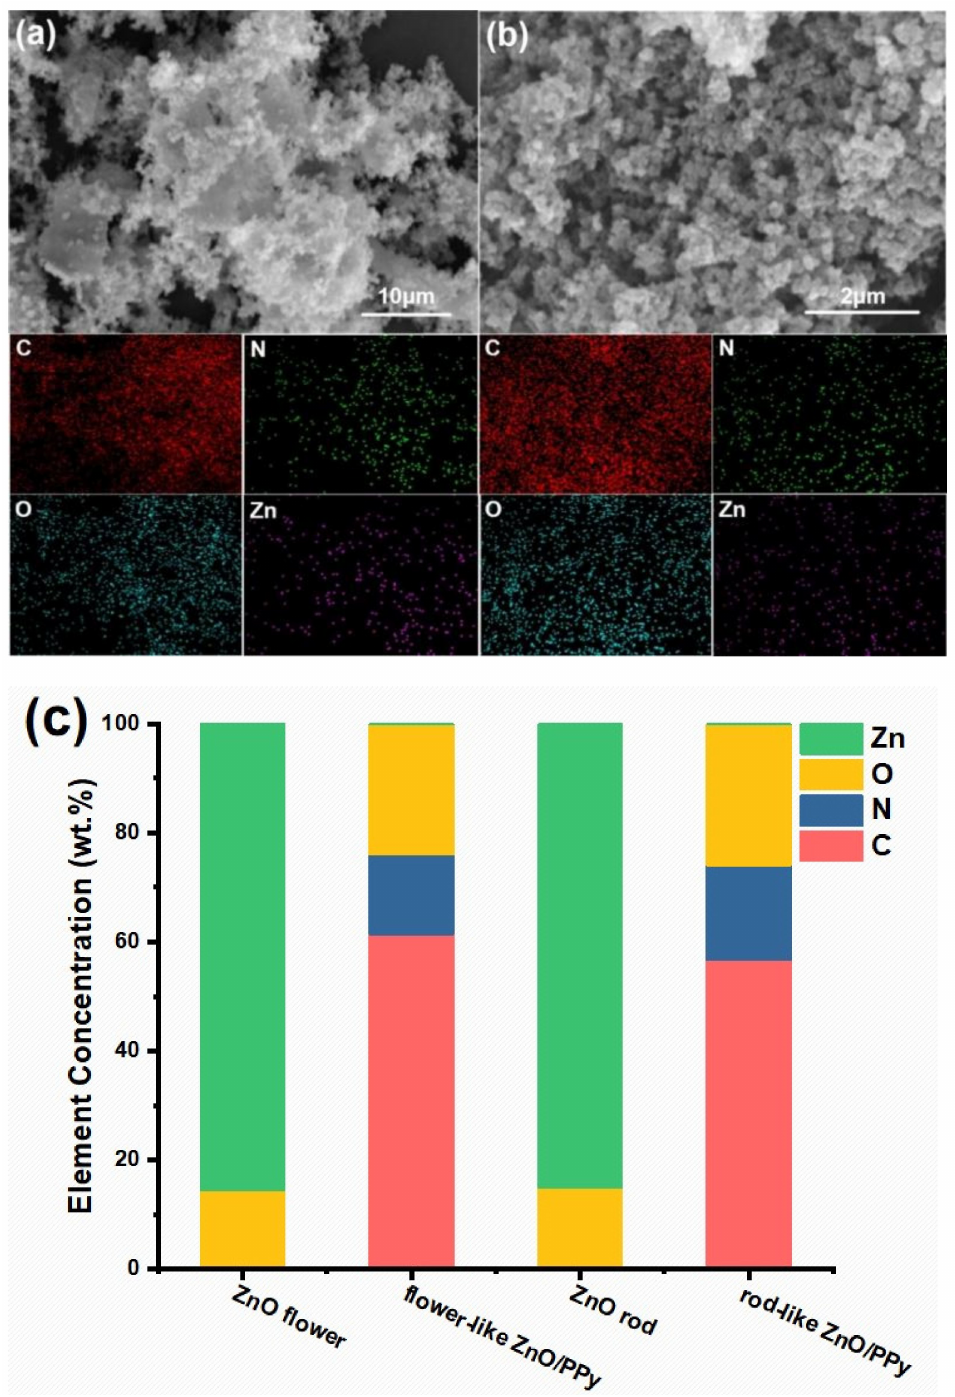
Figure 3. EDS mapping images of ( a ) flower-like ZnO/PPy composites and ( b ) rod-like ZnO/PPy composites; ( c ) quantitative analysis of ZnO flowers, ZnO rods, and corresponding ZnO/PPy